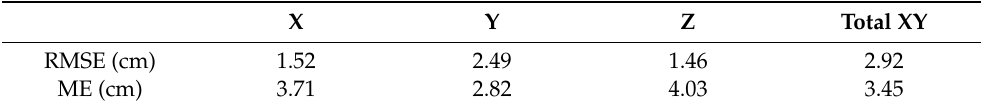
Table 2. Evaluation of the accuracies of SfM models based on DJI 4K cameras. X represents longitude, Y represents latitude, and Z represents altitude. Spatial root mean square error (RMSE) and spatial mean error (ME) are between the surveyed coordinates of the ground control points (GCPs) in the field and coordinates of those in the sparse cloud